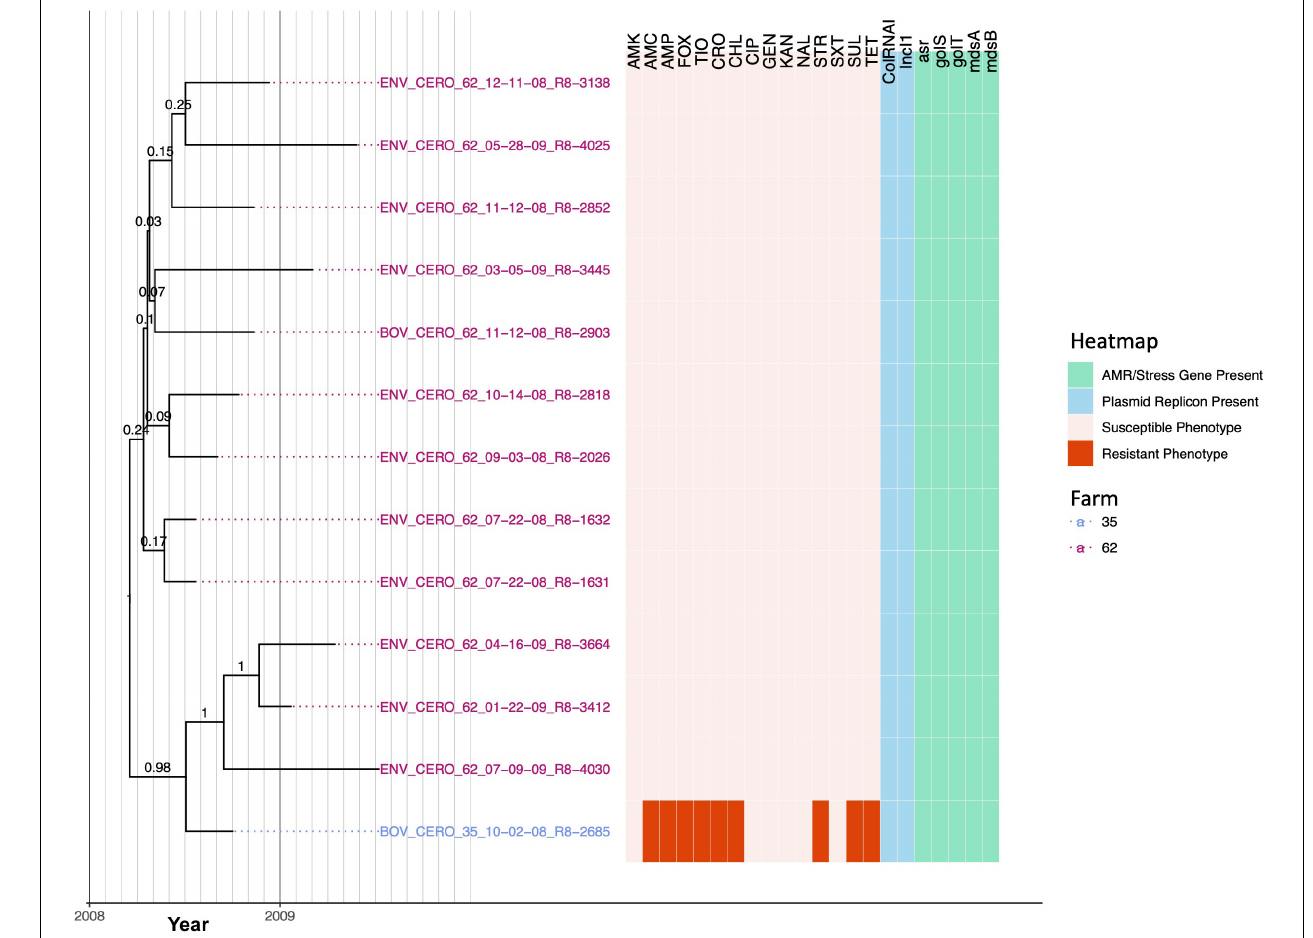
FIGURE 6 | Rooted, time-scaled maximum clade credibility (MCC) phylogeny constructed using core SNPs identified among 13 Salmonella Cerro genomes isolated from subclinical bovine sources and the surrounding bovine farm environment. Tip label colors denote the ID of the farm from which each strain was isolated. Branch labels denote posterior probabilities of branch support. Time in years is plotted along the X -axis, and branch lengths are reported in years. The heatmap to the right of the phylogeny denotes (i) the susceptible-intermediate-resistant (SIR) classification of each isolate for each of 15 antimicrobials (obtained using phenotypic testing and NARMS breakpoints; orange); (ii) presence of plasmid replicons (detected using ABRicate/PlasmidFinder and minimum nucleotide identity and coverage thresholds of 80 and 60%, respectively; blue); (iii) presence of antimicrobial resistance (AMR) and stress response genes (identified using AMRFinderPlus and default parameters; green). Core SNPs were identified using Snippy. The phylogeny was constructed using the results of ten independent runs using a strict clock model, the Standard_TPM1 nucleotide substitution model, and the Coalescent Bayesian Skyline population model implemented in BEAST version 2.5.1, with 10% burn-in applied to each run. LogCombiner-2 was used to combine BEAST 2 log files, and TreeAnnotator-2 was used to construct the phylogeny using common ancestor node heights. Abbreviations for the 15 antimicrobials are: AMK, amikacin; AMC, amoxicillin-clavulanic acid; AMP, ampicillin; FOX, cefoxitin; TIO, ceftiofur;